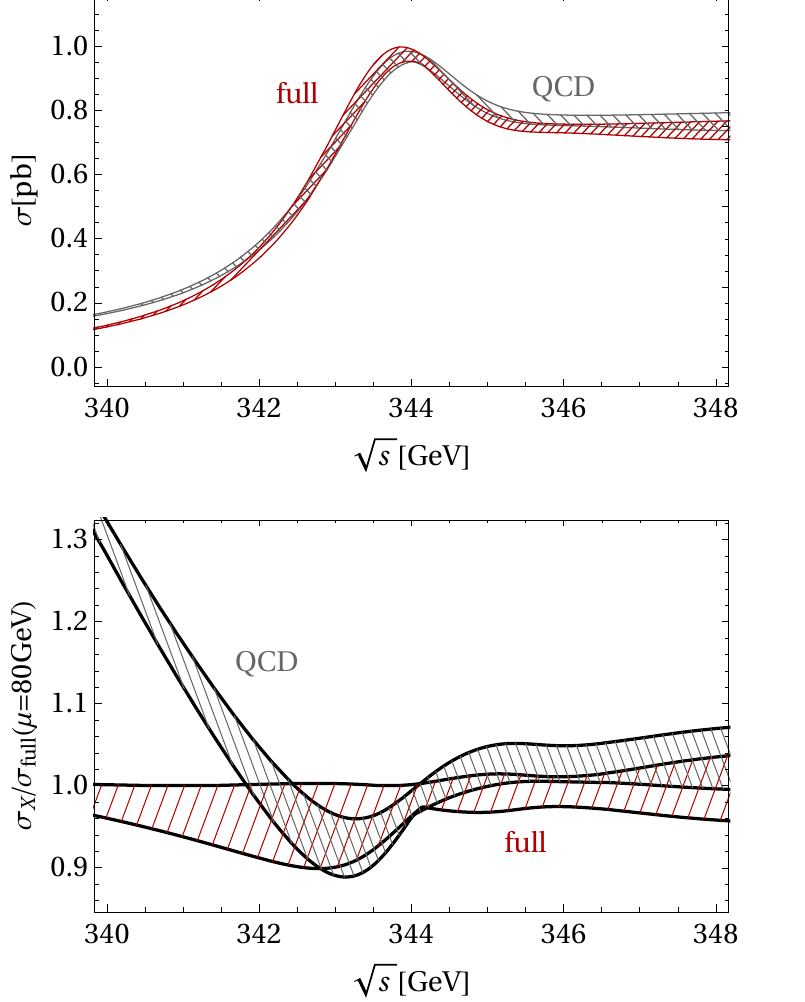
Figure 10 . The cross section in pure QCD (grey hatched band) and including the electroweak and non-resonant corrections (red hatched band). The bands represent the uncertainty from scale variation. The upper panel shows the cross section in pb and the lower panel shows the results normalized to the full one for the central scale (cid:22) r = 80